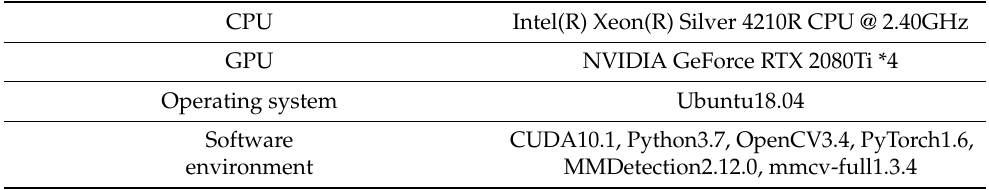
Table 1. The experimental